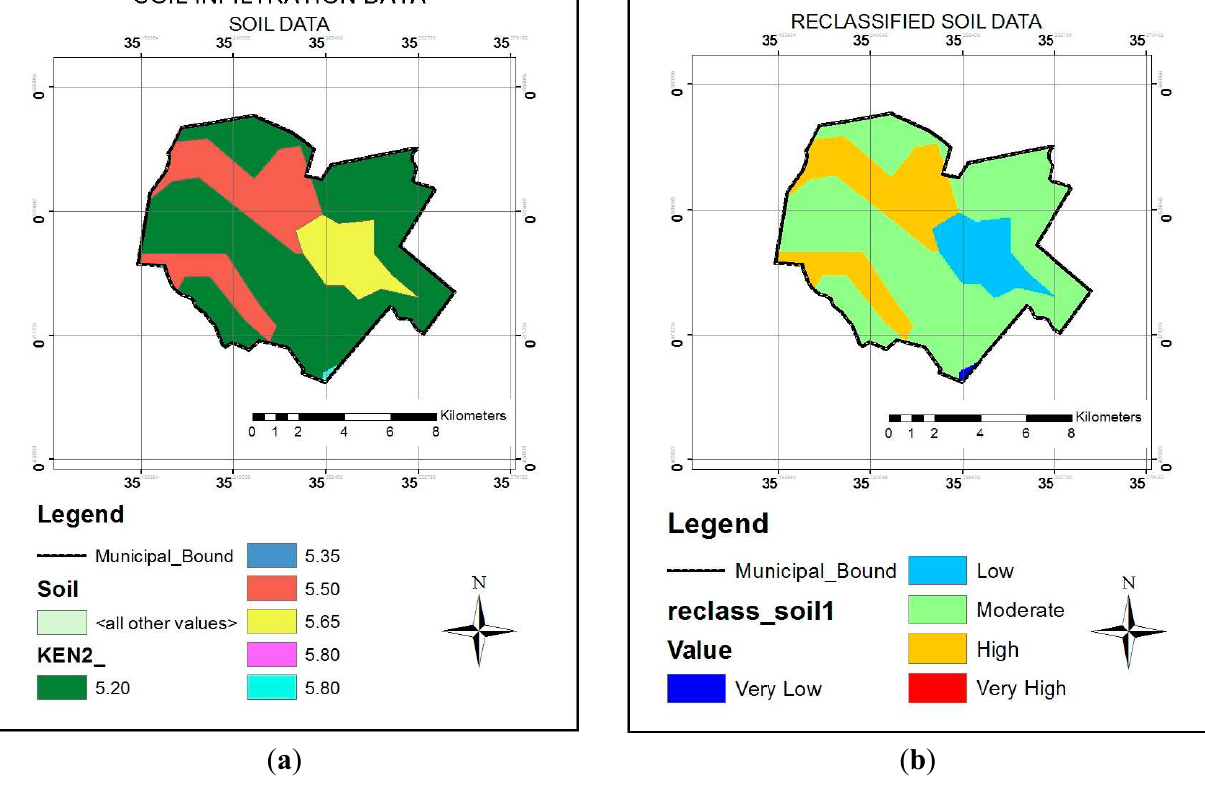
Figure 10. Raster map of: ( a ) rainfall data; ( b ) Inverse Distance Weighting (IDW) interpolated rainfall surface and ( c ) reclassified rainfall